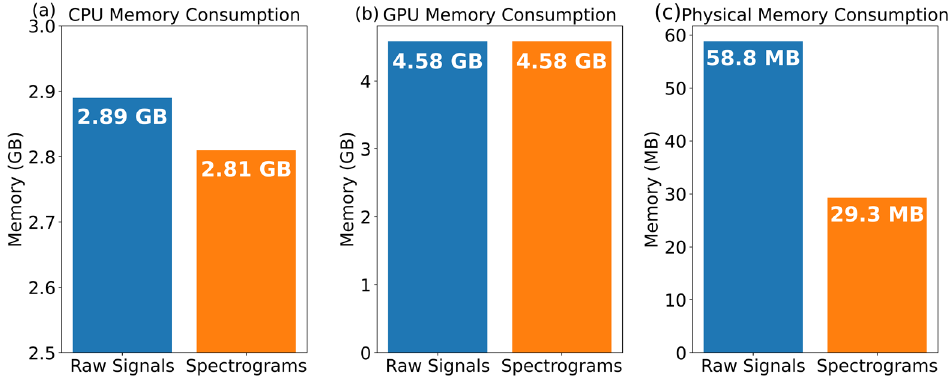
Figure 5. Memory proportion on both datasets: raw signals and spectrograms.